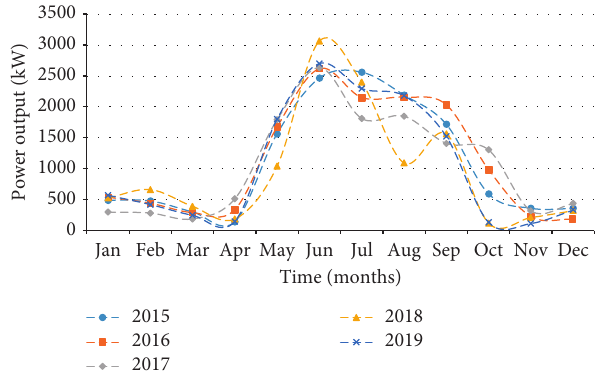
Figure 2: Variation of monthly wind power generation.